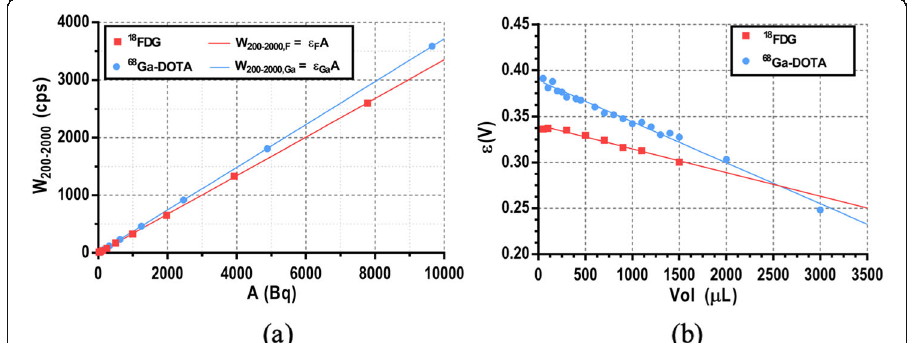
Fig. 4 a Calibration profiles obtained in the well counter for 300- μ l pure 18 F (red squares) and 68 Ga (blue circles) samples with different activity values using the full energy window ( W 200 – 2000 ). Each dataset was fitted to a straight line with y -intercept forced to be 0 obtaining the calibration factors ε F = 0.335cpsBq − 1 and ε Ga = 0.371cpsBq − 1 at this volume. b Variation of calibration factors with the sample volume for 18 F ( ε F ) and 68 Ga ( ε Ga